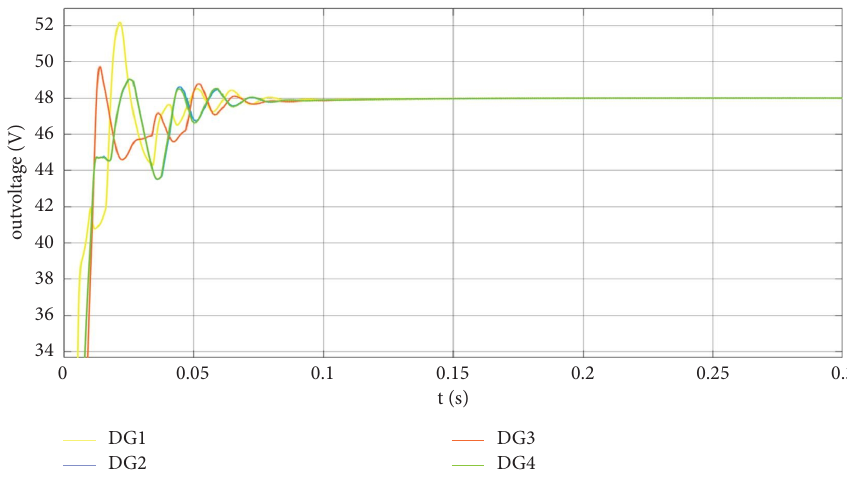
Figure 5: Output voltage considering input delay.